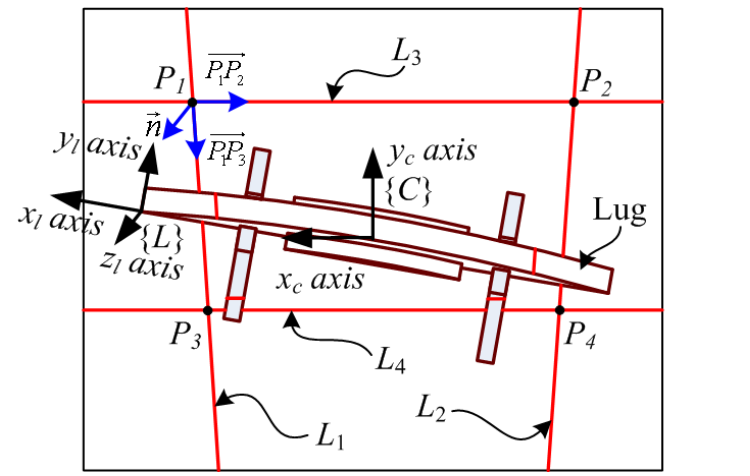
, D , D and D , 1 2 3 4